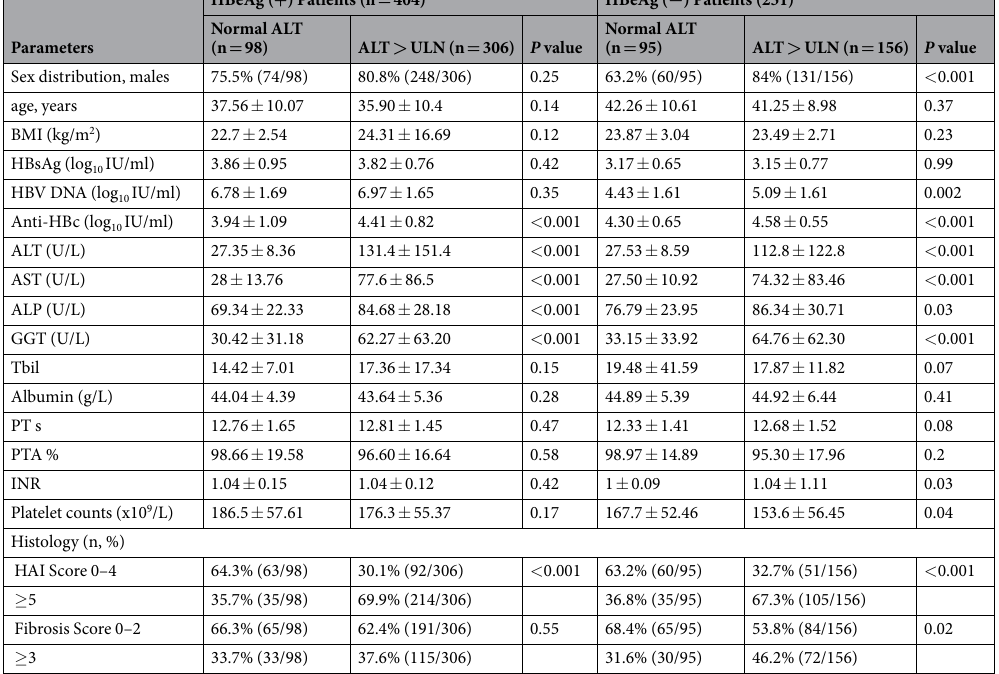
Table 1. Clinical characteristics of patients with chronic hepatitis B virus infection. MBI, body mass index; HBsAg, hepatitis B surface antigen; HBeAg, hepatitis B e antigen; anti-HBc, hepatitis B core antibody; ALT, alanine aminotransferase; AST, aspartate aminotransferase; ALP, alkaline phosphatase; GGT, gamma-glutamyl transpeptidase; Tbil, total bilirubin; PT, prothrombin time; PTA, prothrombin time activity; INR, international normalized ratio; HAI, histology activity